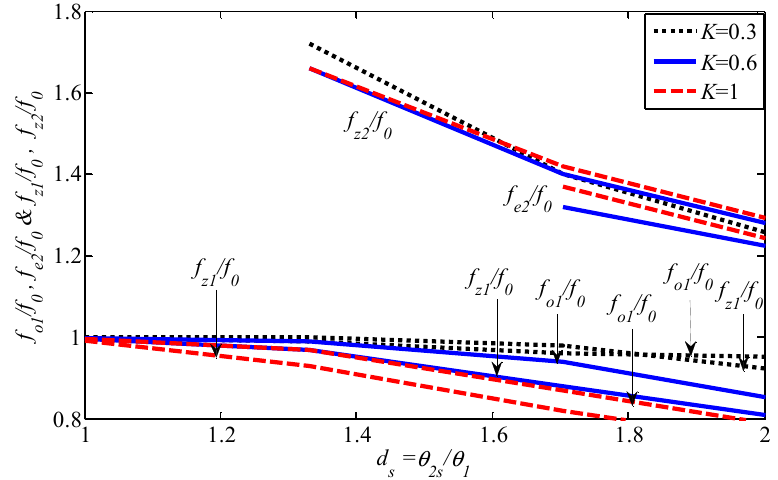
Figure 7. Resonant frequencies and TZ’s for length λ g / 2 short-ended stubs.